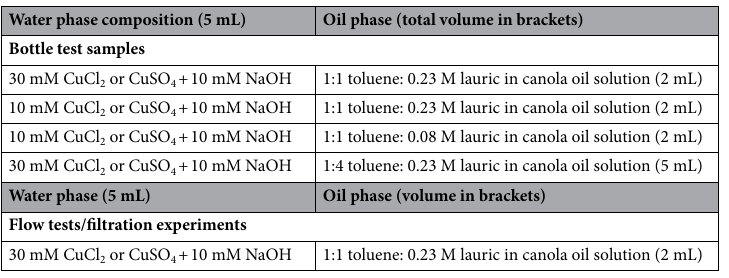
Table 2. Samples used for ICP-OES